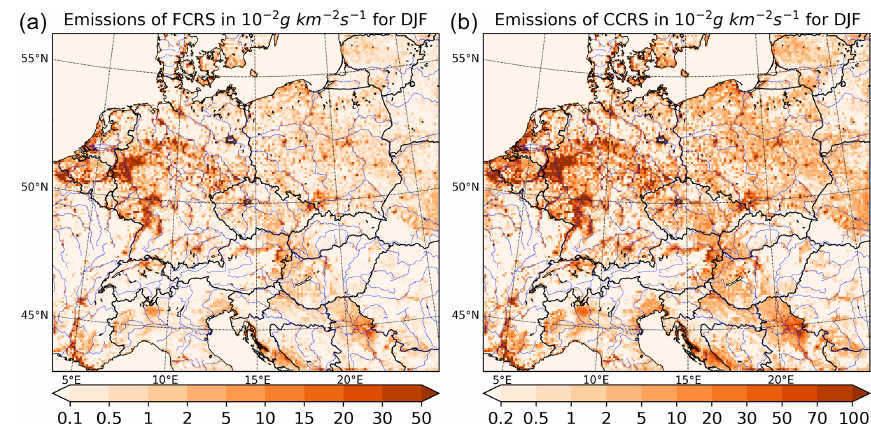
Figure 2. Average WBD emission fluxes of fine crustal material (FCRS; a ) and of coarse crustal material (CCRS; b ) above central Europe in DJF for the 2007–2016 period (in 10 − 2 gs − 1 km − 2 ). Note that the colour bars differ.